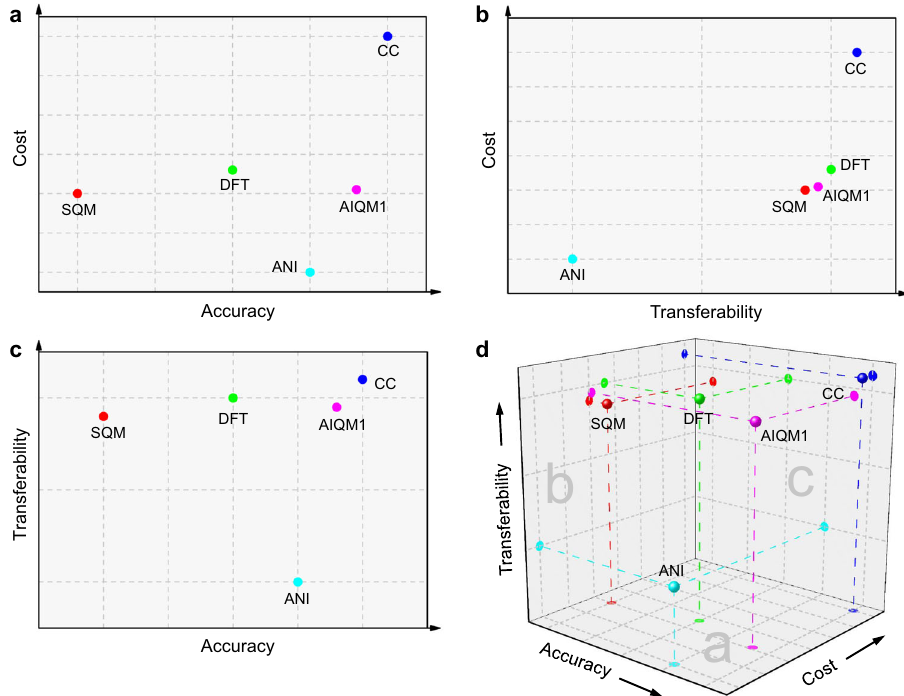
Fig. 1 Simpli fi ed scheme of quantum chemistry approximations. Traditional quantum mechanical approaches such as the gold-standard coupled cluster (CC, blue), work-horse density functional theory (DFT, green), fast and approximate semiempirical quantum mechanical (SQM, red) methods, arti fi cial intelligence-based ANI (cyan), and the new arti fi cial intelligence – quantum mechanical method 1 (AIQM1, magenta). They are compared with respect to a cost and accuracy, b cost and transferability, c accuracy and transferability, and d cost, accuracy, and transferability. The accuracy of ANI is with